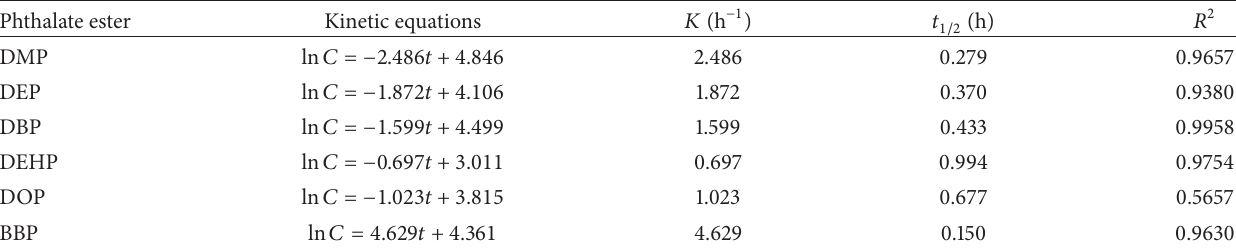
Table2:Therateconstantsandhalf-lifeofactivatedsludgeadsorbingPAEsfittingfirst-orderreaction(initialPAEconcentrationwas80 𝜇 g/L). Phthalate